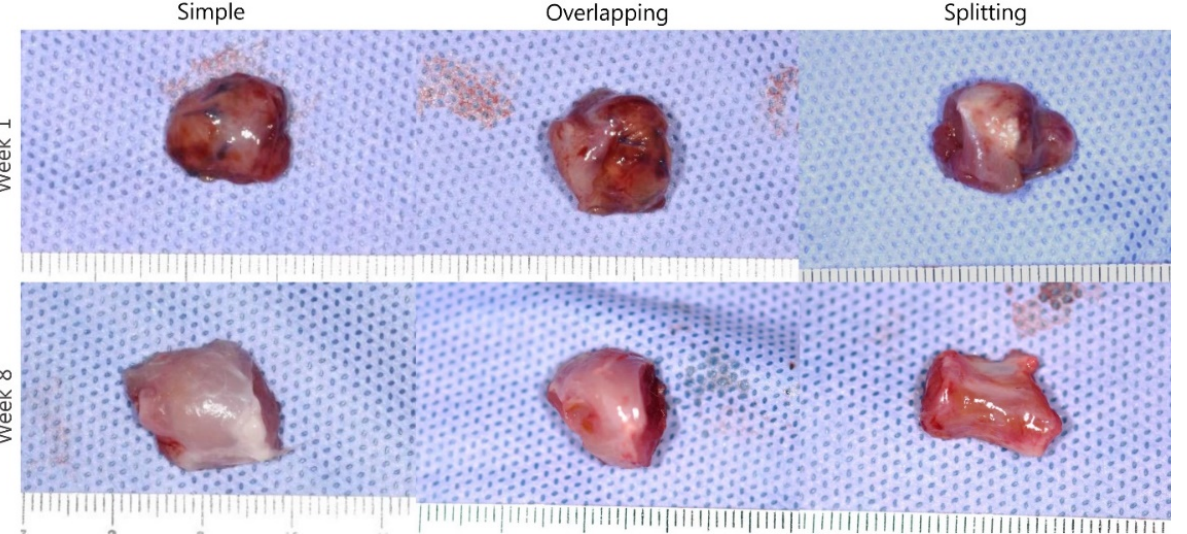
Figure 9. Gross examination.